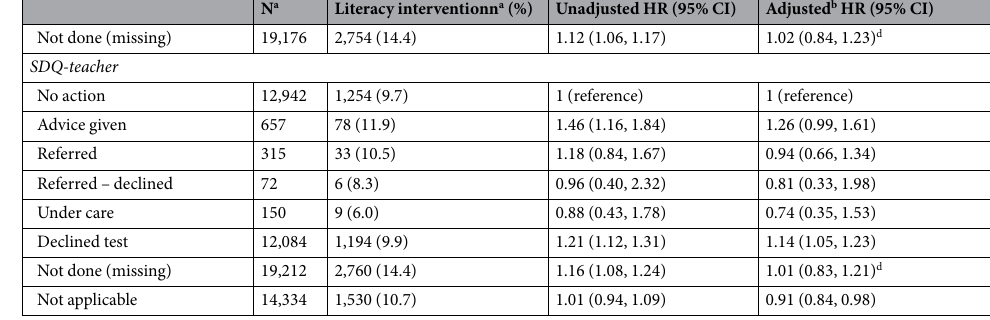
Table 2. Numbers (%) of B4SC cohort who had at least one literacy intervention by selected demographics, together with unadjusted and adjusted hazard ratios (HRs) and associated 95% confidence intervals (CIs). Note: a Randomly rounded to base 3, as per the confidentiality rules of SNZ. b Adjusted for all variables listed in Table 3. c Includes children with level II information who were not Samoan, Cook Island Māori, or Tongan; children with two or more Pacific ethnic identifications; and, Pacific children with only level I information available. d Estimates determined by omitting collinear indicator